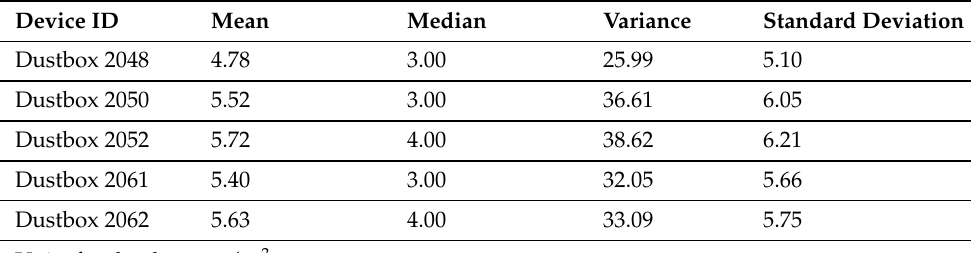
Table 2. Summary statistics of five Dustboxes at 1 min sampling